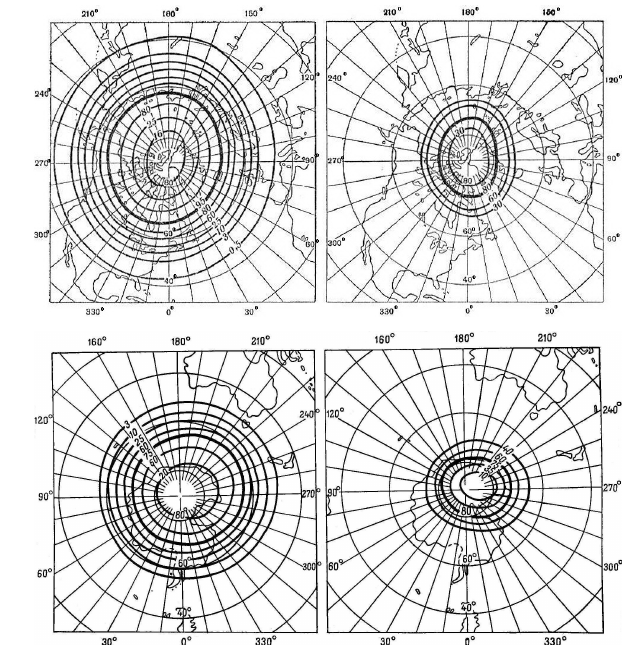
Figure 4. System of “isoaurora” lines for both the Northern (top panels) and Southern Hemispheres (bottom panels). The left-hand side panels show their distribution during nighttime hours, the right- hand side panels correspondingly those for daytime hours (Feld- stein, 1963a).